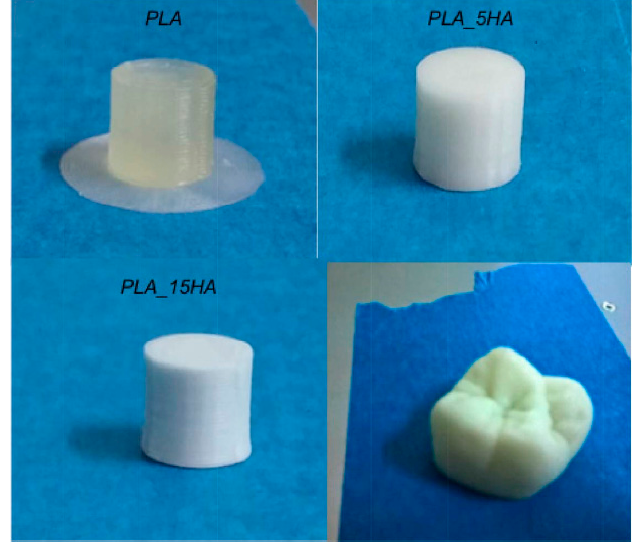
Figure 5. PLA/HA nanocomposites by FDM 3D printer. Reproduced with permission from [48].